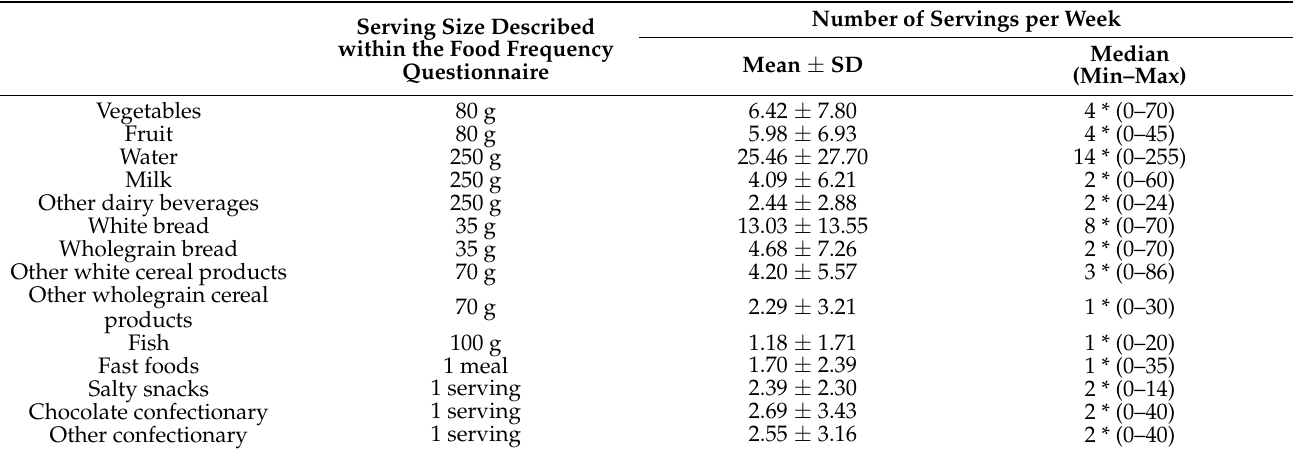
Table 4. The results of the Acne-specific Food Frequency Questionnaire (Acne-FFQ) in the studied group of male adolescent participants of the